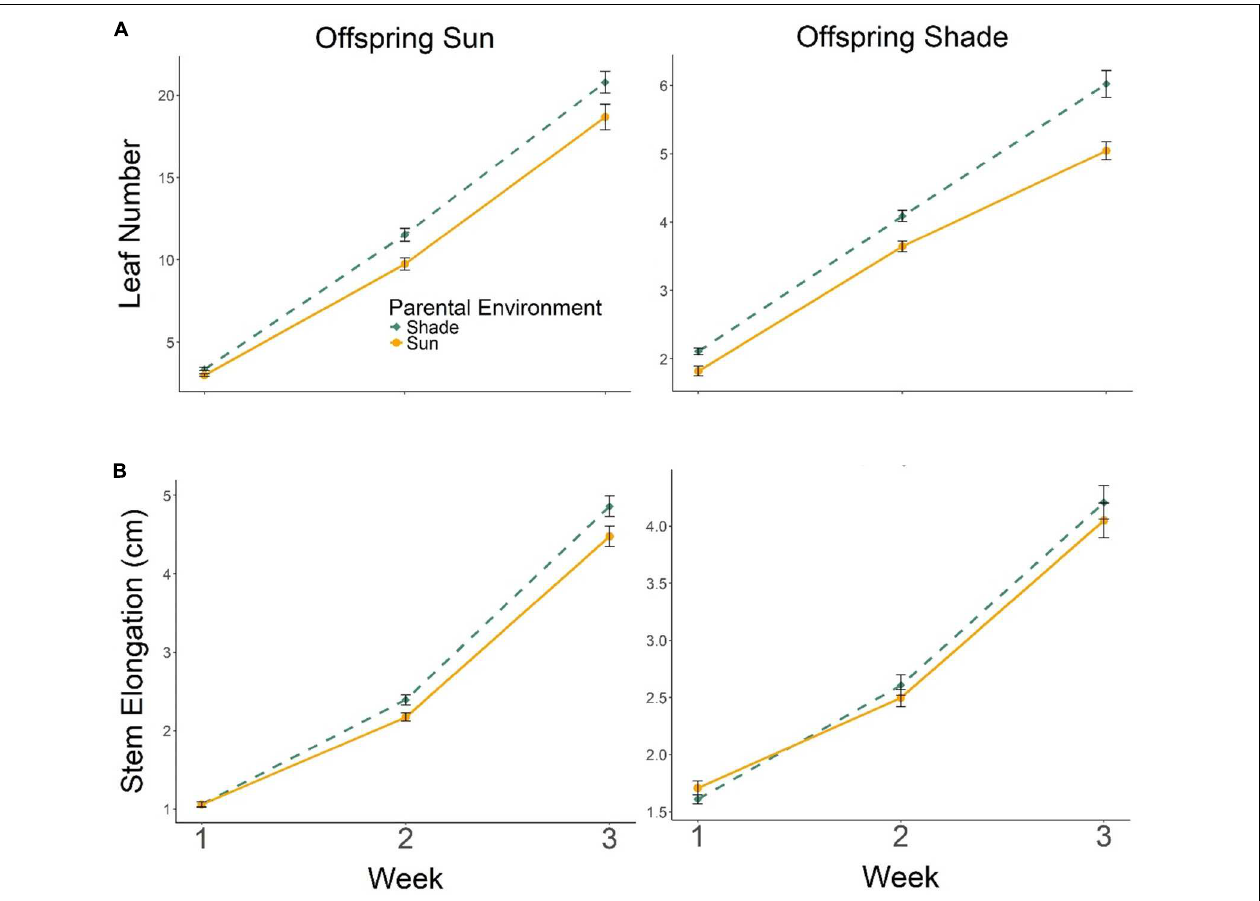
FIGURE 3 | Means ± SE shown ( N = 185) for (A) leaf production and (B) stem elongation over 3 weeks growth for offspring of Parental Shade (dashed green line) and Parental Sun (solid yellow line) plants that were grown either in Offspring Shade or Offspring Sun